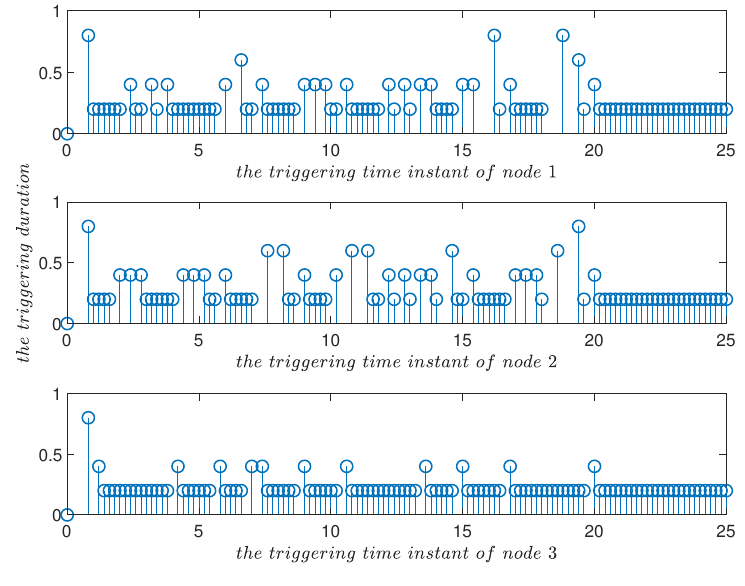
Figure 11. Triggering time instants and their duration in the improved event-triggered scheme for (cid:101) 1 ( t ) = 0.05 in Example 1. Compared with Figure 12, triggering parameter (cid:101) 1 ( t ) played a role in adjusting the triggering